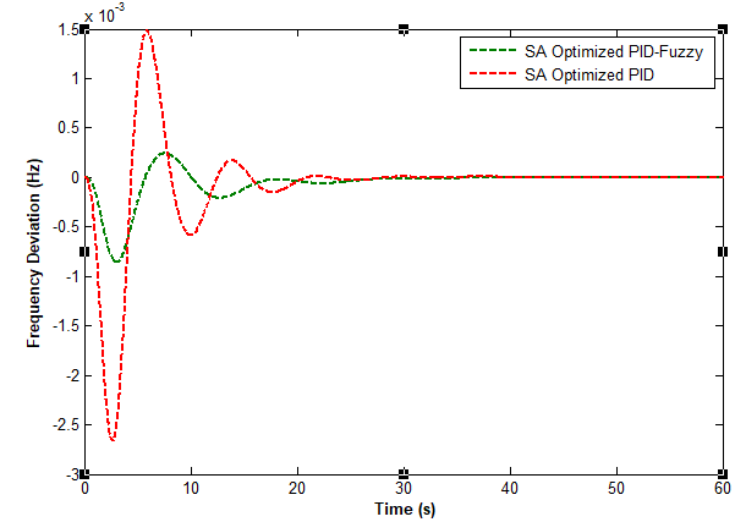
Figure 7. Frequency deviations in area 1 for the first